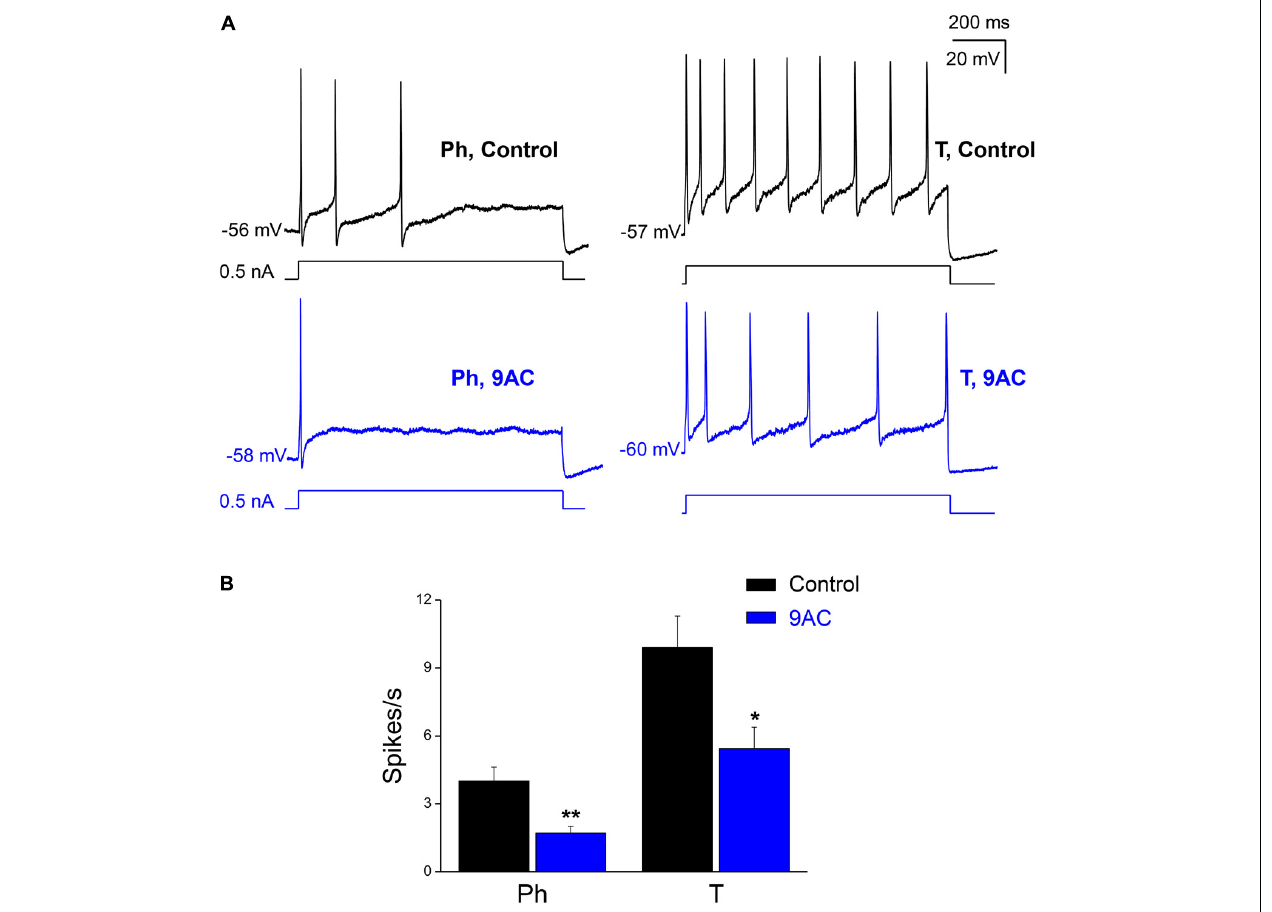
FIGURE 2 | The chloride channel blocker 9AC diminishes firing frequency in both Ph and T neurons. (A) Repetitive firing of a Ph (left) neuron in control solution after the injection of 0.5 nA depolarizing current (black upper traces) and its modification after the addition of 2 mM 9AC (blue lower traces). The same effect in a T neuron (right). The injected current protocol is shown in each recording below the membrane potential. The RMP of cells is indicated at the beginning of each recording. Calibration bars apply to both panels. (B) Significant reduction of firing frequency elicited with 1.0 nA depolarizations in the presence of 2 mM 9AC for both populations of Ph ( n = 9) and T sympathetic neurons ( n = 9). Paired t -test: ∗ P < 0.05; ∗∗ P <